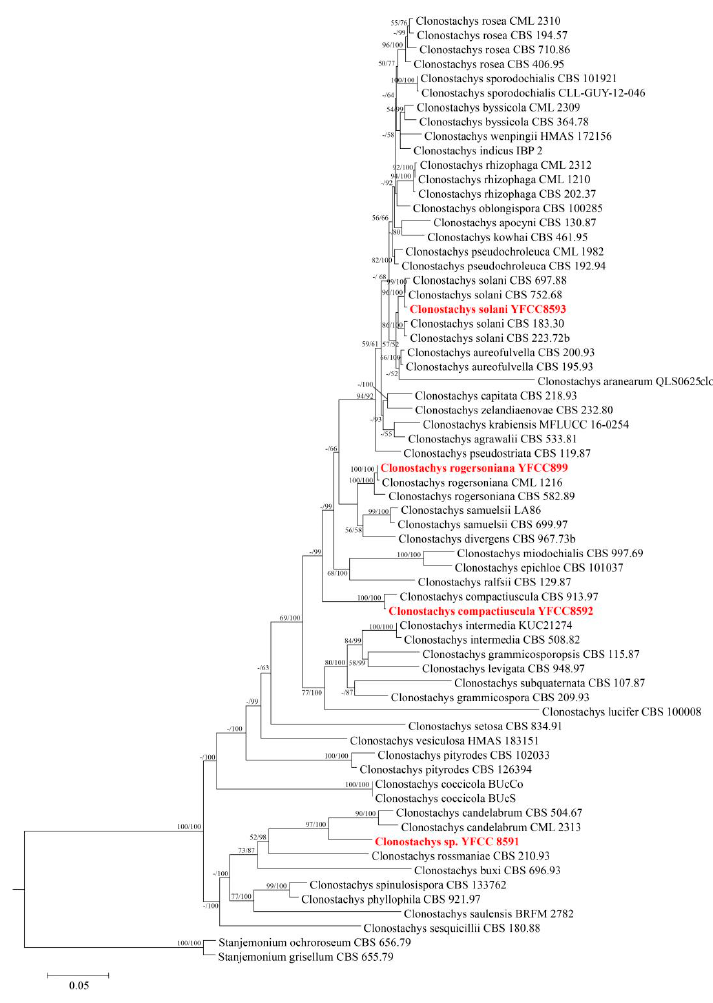
Figure 2. Phylogenetic tree of Clonostachys genus by the analysis of three genes ( nrLSU + Tub + ITS) dataset.